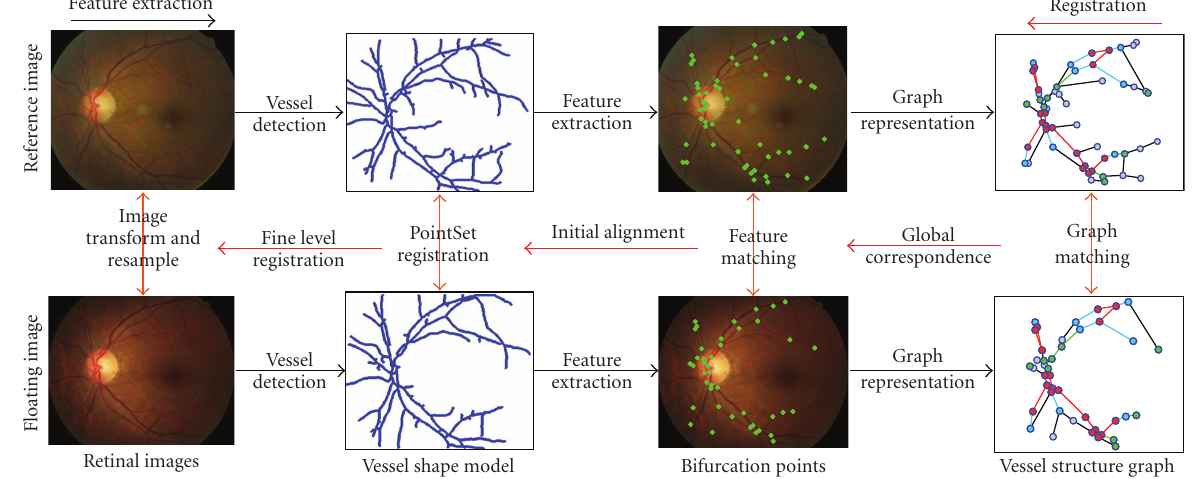
Figure 1: Hierarchical retinal image feature extraction and registration framework proposed in this paper. From left to right is the process of feature extraction, including vessel detection, vascular bifurcations extraction, and graph-based representation. From right to left represents the two-step registration procedure, consisting of graph matching and ICP-based vessel shape model registration.